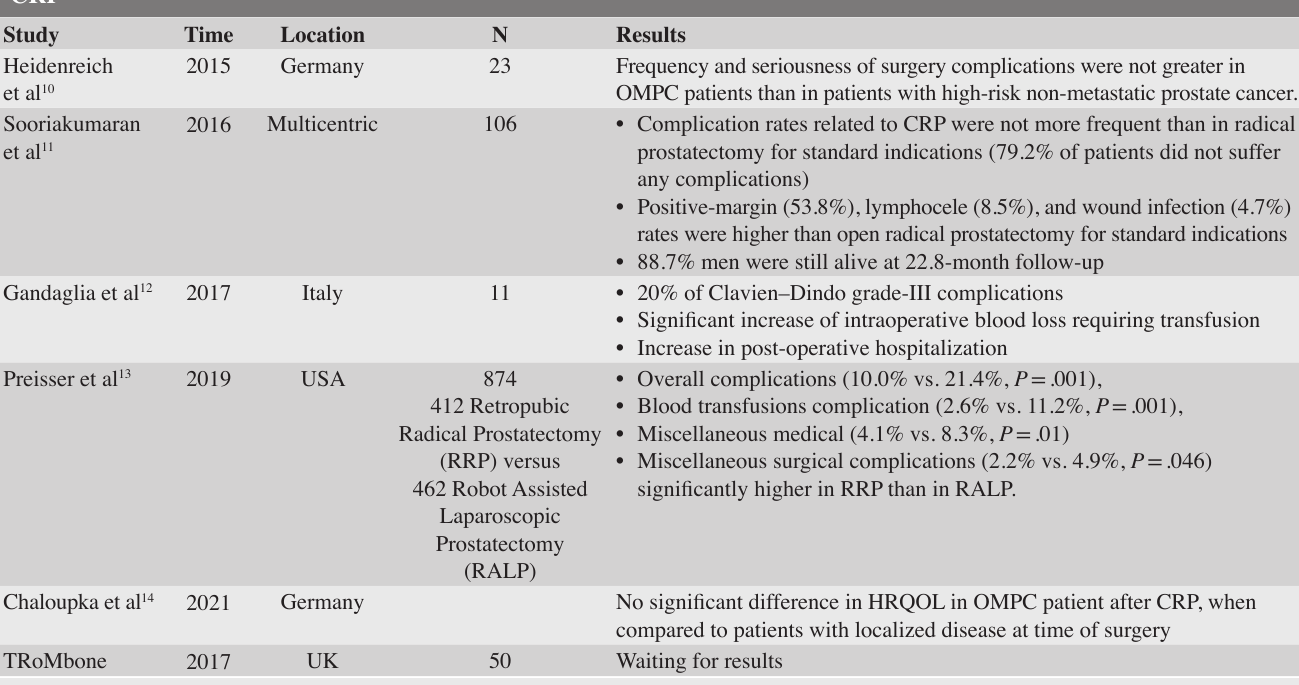
Table 1. Summary of Studies Reporting Safety, Feasibility, and Quality of Life of OMPC Patients Who Underwent